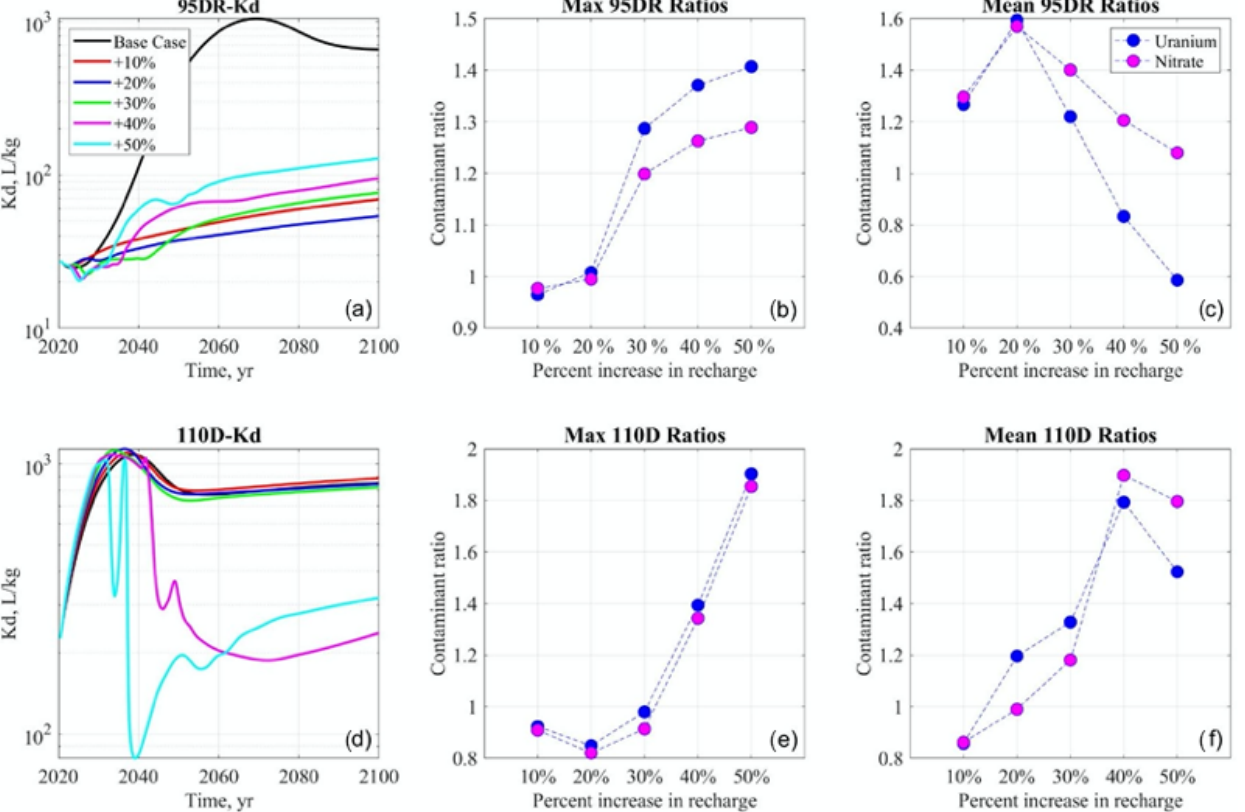
Figure 7. Breakthrough curves for K d at the source-zone well (a–c) and the downgradient well (d–f) for the increasing recharge scenario from 2020 to 2100. Maximum and average ratios of base case to increased recharge case for uranium and nitrate concentrations at both well